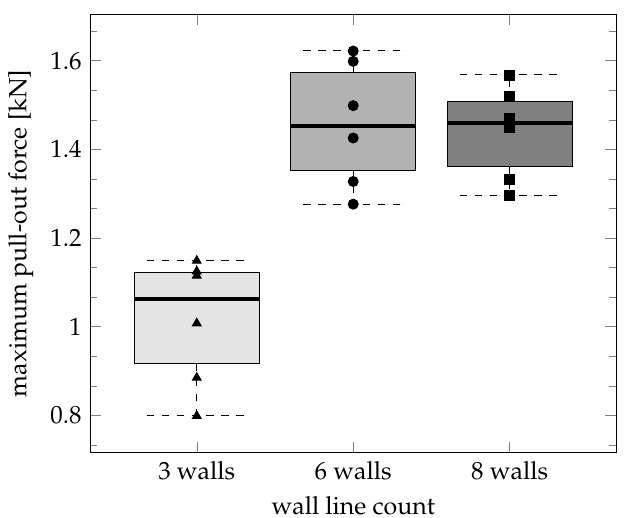
Figure 10. Maximum pull-out forces for variations of the wall thickness (six specimens